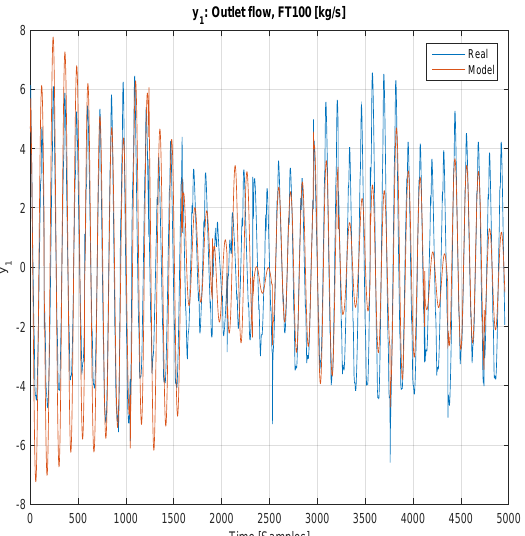
Figure 12: Model ( L = 20 , J = 23 , n = 5) simulated over the identification set. MSE = 2 . 4207. Case B